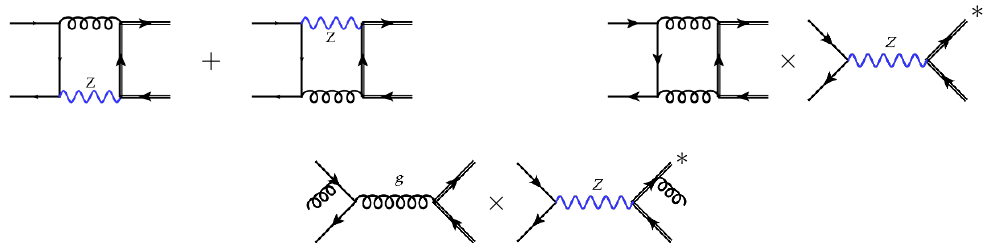
Figure 4 . Diagrams and diagram interferences containing infrared singularities from soft and collinear gluons in the q (cid:22) q initial